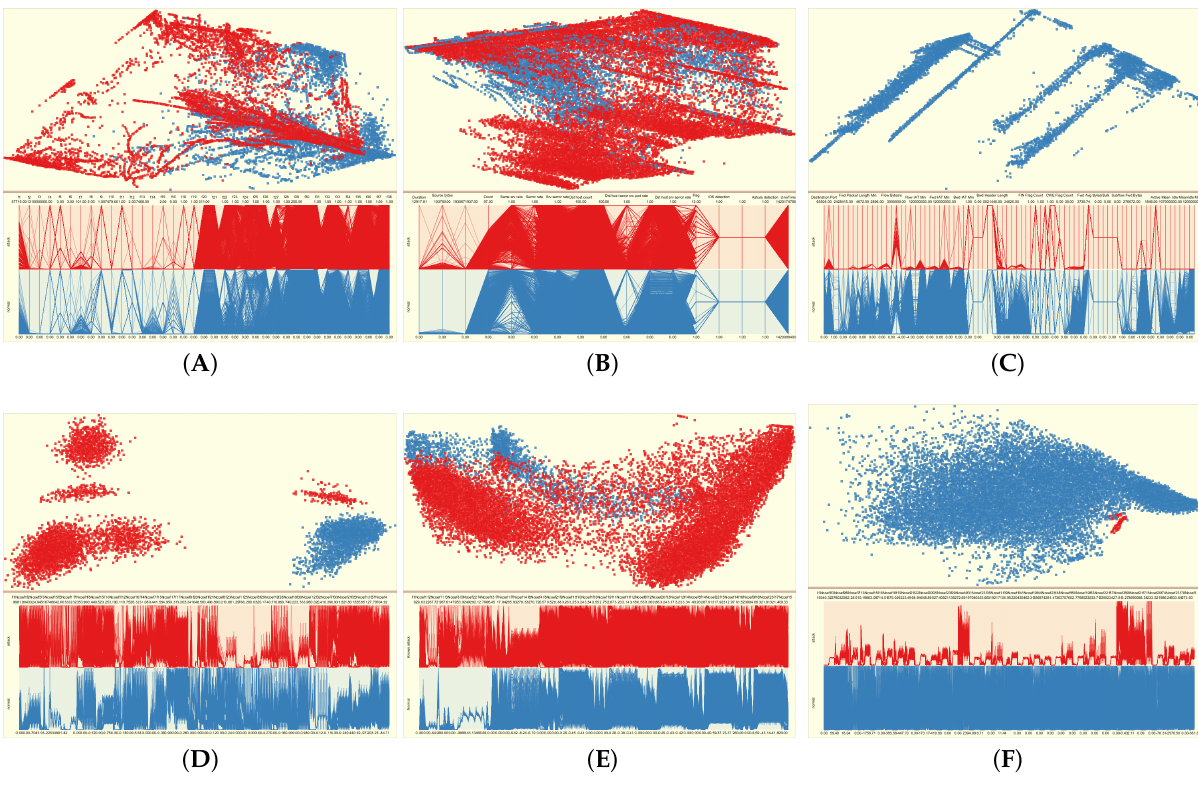
Figure 1. Visual representations of intrusion detection datasets. ( A – C ) represent the original raw features of the datasets. ( D – F ) show the analyzed the DWT features ( α = 150 and β = 10). All network traffic instances are mapped to blue- and red-colored glyphs to represent normal and attack events, respectively. ( A ) NSLKDD Raw Features; ( B ) Kyoto2006 Raw Features; ( C ) CICIDS2017 Raw Features; ( D ) NSLKDD DWT Features; ( E ) Kyoto2006 DWT Features; ( F ) CICIDS2017 DWT